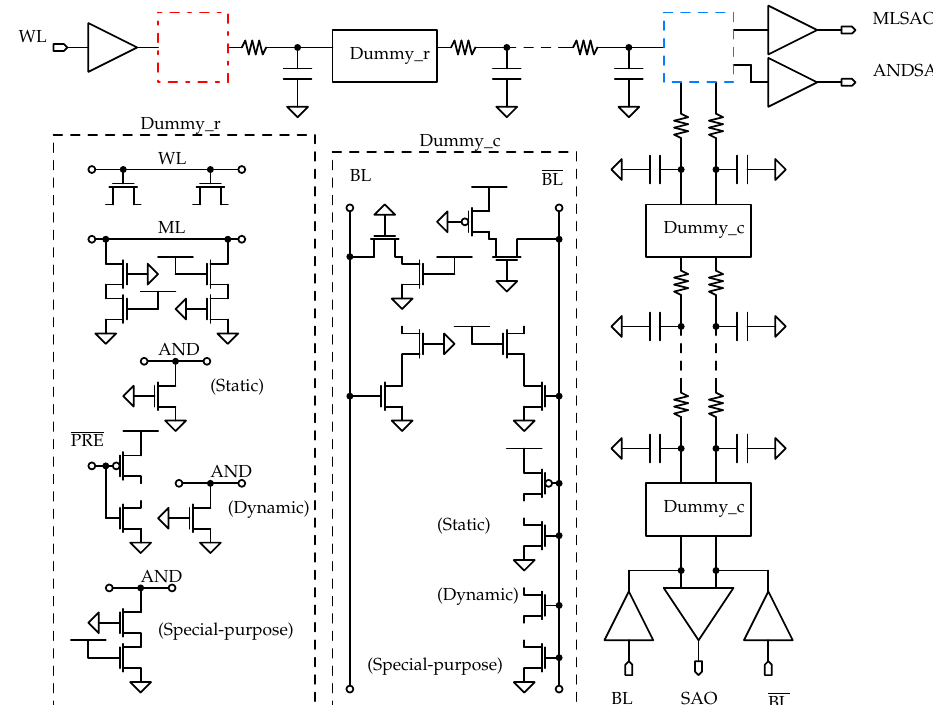
Figure 14. The array model. The first row correspond to the top one, while the fist column with the leftmost one. Only the critical cells for the read, write, search and AND operations are actually included in the array, as layout-extracted circuits, while all the others are substituted by dummy rows and columns, extracted from the layout, that contain only the significant transistors (i.e., the ones connected to the row/column signals in the original